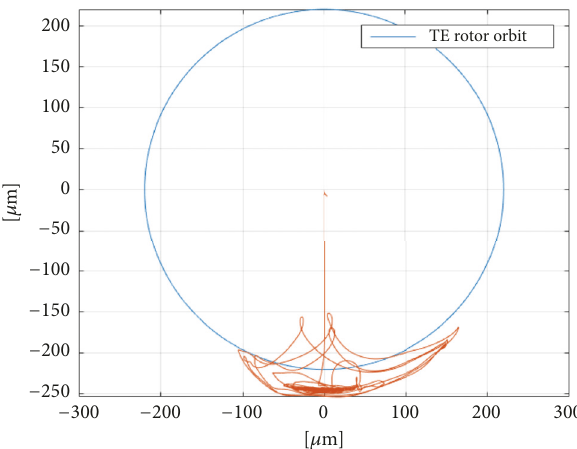
Figure 17: Predicted rotor orbit during a landing test (DE node).